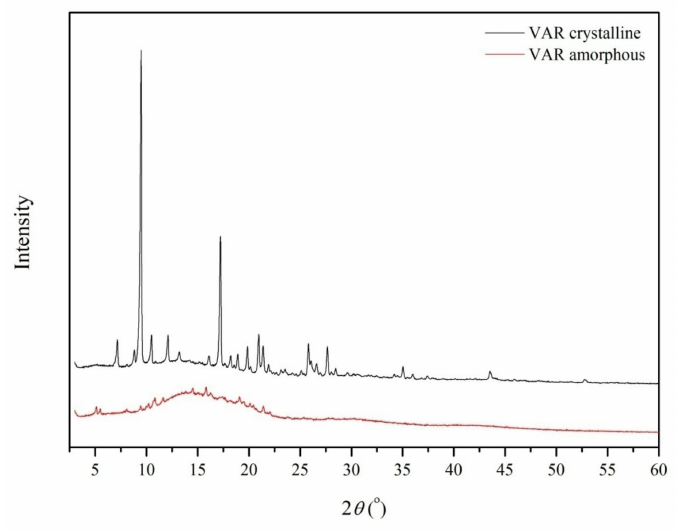
Figure 1. X-ray powder diffraction (PXRD) of crystalline and amorphous forms of vardenafil hy- drochloride (VAR).